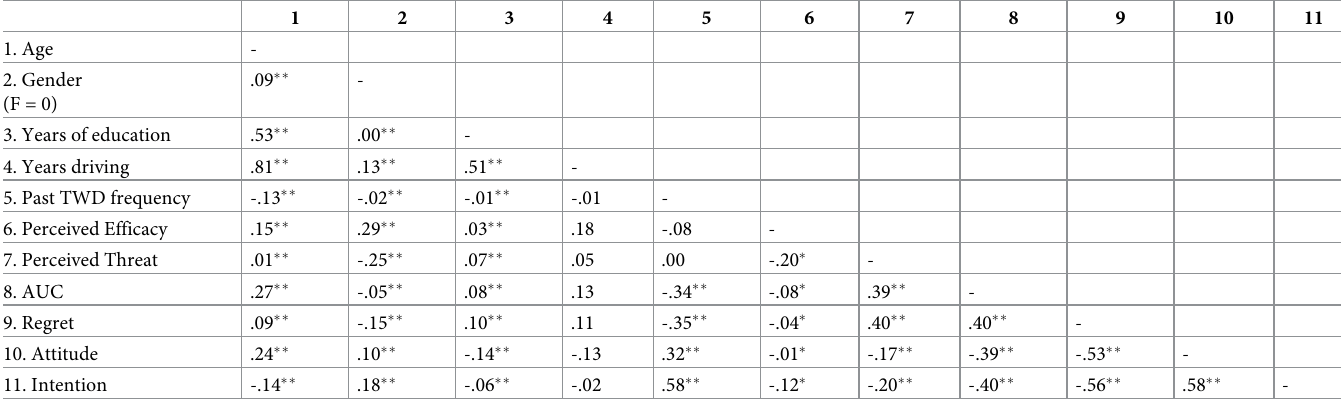
Table 2. Pearson correlation coefficients among demographic characteristics, perceived efficacy and threat, and TWD-Related measures. 1